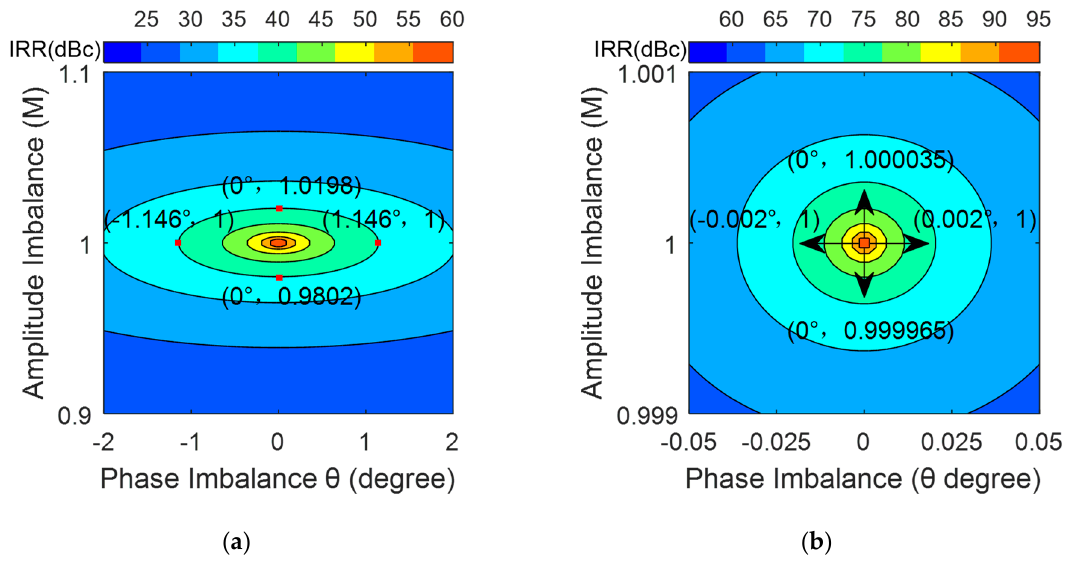
Figure 4. The simulated IRR as functions of the amplitude imbalance M and the phase imbalance θ , suppose φ = 0. ( a ) The IRR versus M and θ ; ( b ) The zoom ‐ in view for the case when IRR > 60 dBc.